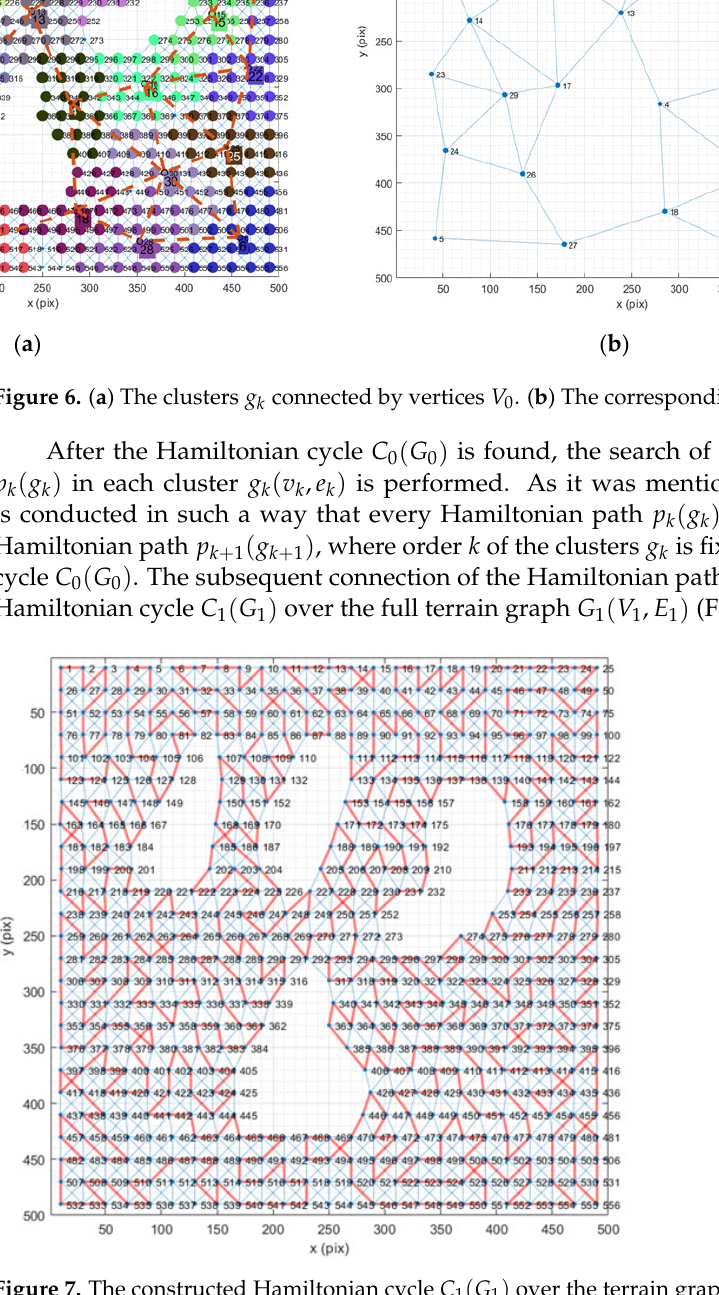
Figure 7. The constructed Hamiltonian cycle C 1 ( G 1 ) over the terrain graph G 1 . Formulation of the total algorithm for terrain graph construction and search of the Hamiltonian circuit is presented in Algorithm 1 as MATLAB-like pseudo-code.